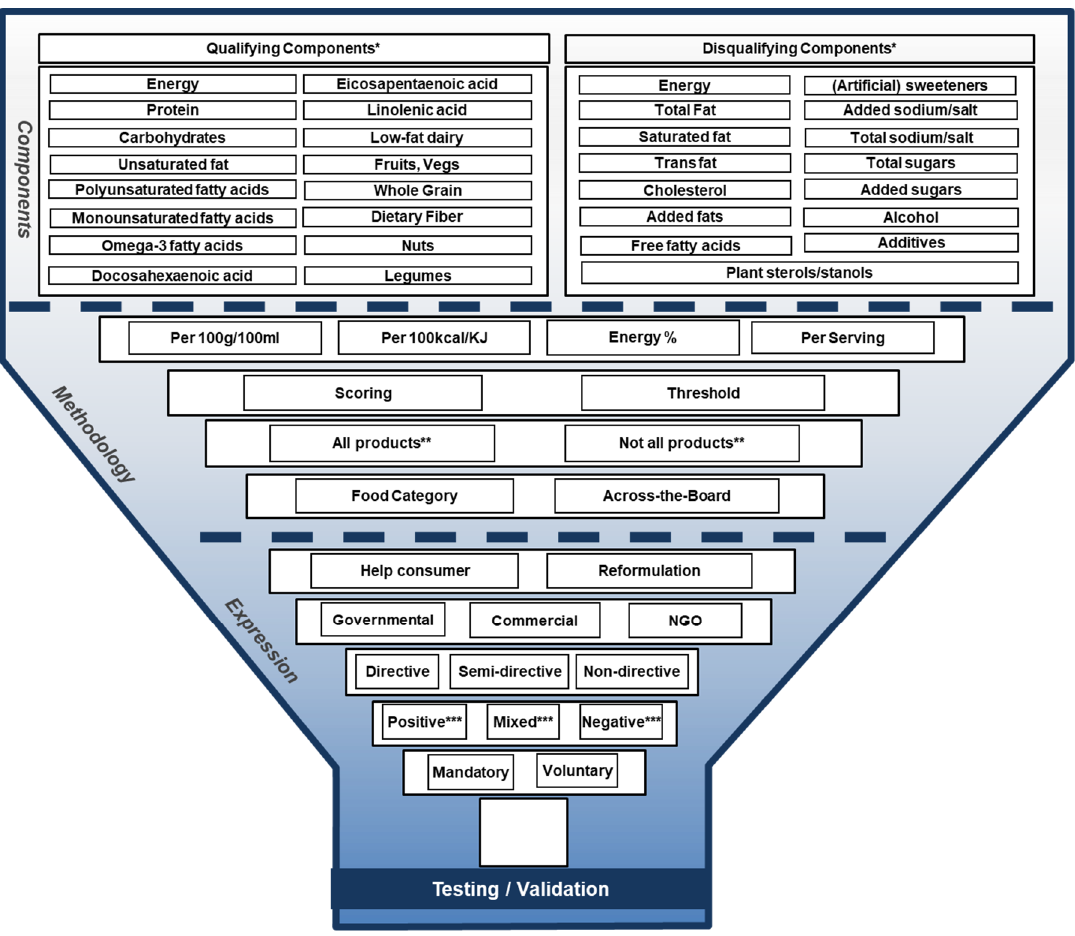
Figure 1. The Funnel Model describing functional and visual aspects of front-of-pack (FOP) labels in Europe. *‘Ingredients’ in the 2014 Funnel Model was replaced by ‘components’. **Coverage was added to the 2014 Funnel Model as an additional FOP label characteristic. ***Tone of voice was added to the 2014 Funnel Model as an additional FOP label characteristic.